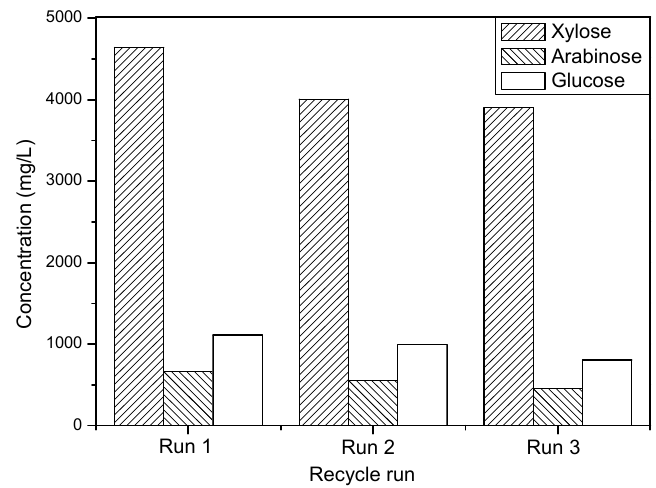
Figure 6. Recyclability of the bamboo-derived magnetic solid acid (pretreated by 0.25% H 2 SO 4 ).